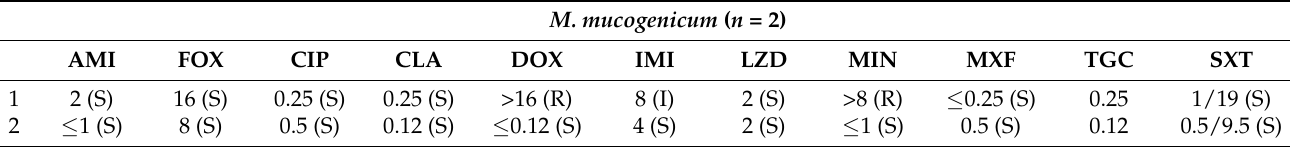
Table 8. Results of in vitro susceptibility testing for M. mucogenicum